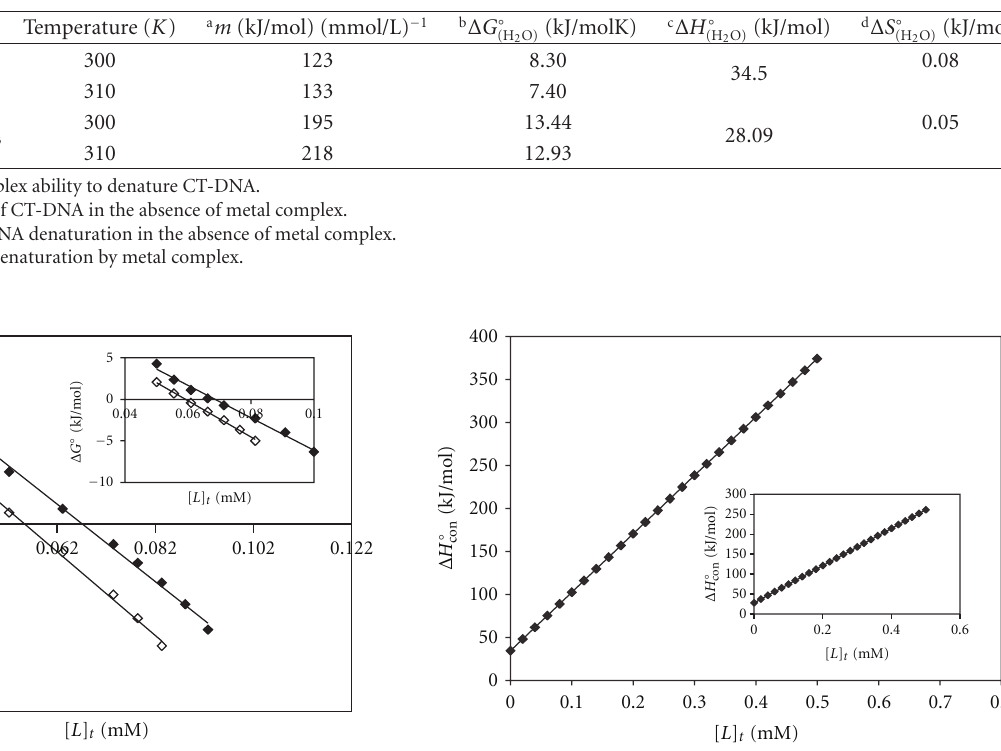
Table 1: Thermodynamic parameters of CT-DNA denaturation by palladium(II) and platinum(II) complexes. Compound